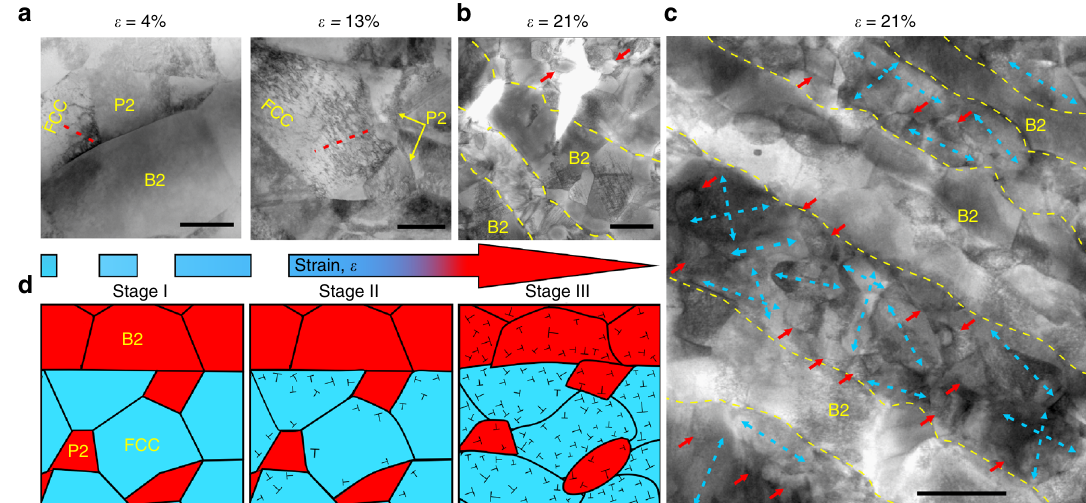
Fig. 3 Deformation micro-mechanisms in the hierarchical DPHL HEA with the increasing tensile strain. a STEM images showing the dislocation- substructure evolution. The early stage of deformation ( ɛ = 4%) leads to more obvious dislocations in soft FCC grains than hard P2 (the intergranular B2 grains) and B2 grains near phase interfaces. At medium strains ( ɛ = 13%), there exhibit signi fi cantly-increased dislocations in FCC grains and P2. The piling-up of GNDs is marked by dashed red lines in FCC grains. b , c STEM images of the microstructure stretched to fracture ( ɛ = 21%). The dual-phase lamellae and P2 (indicated by yellow dashed lines and red arrows, respectively) show apparent dislocations. b Microcrack propagation stays con fi ned/ blunted by neighboring lamellae. c The dashed blue arrows point out different deformation directions, and even some FCC grains deform along two directions. d Schematic illustration of the dislocation evolution during deformation. Stage I: elastic deformation; Stage II: elastic-plastic deformation; Stage III: plastic deformation. ⊥ , dislocation. Note that stage I in d is not the schematic illustration of ɛ = 4% in a . Scale bars, 200 nm in a , b and 1 µ m in